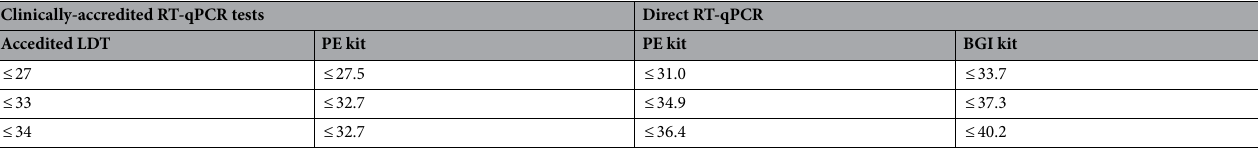
Table 3. Performance of direct RT-LAMP: summary of RT-LAMP performance compared to RT-PCR tests: detection limits for 100%